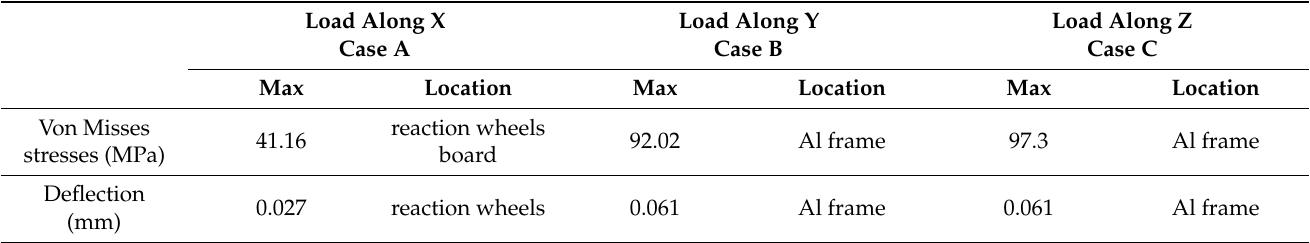
Table 12. Maximum stresses and deformations in each